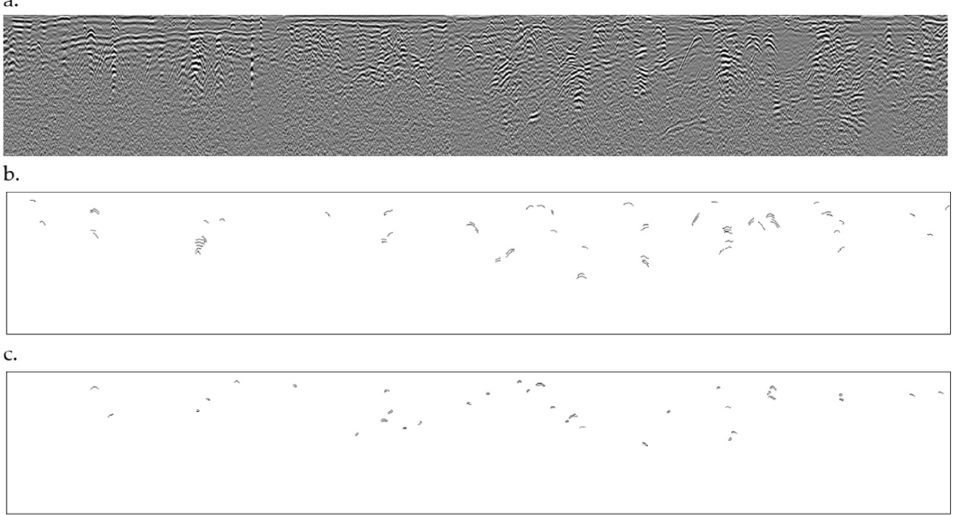
Figure 14. Visualization of the results and showing the differences between proposed methods: ( a ) original GPR image; ( b ) hyperbolas detection result obtained from Method 1; ( c ) hyperbolas detection result obtained from Method 2.